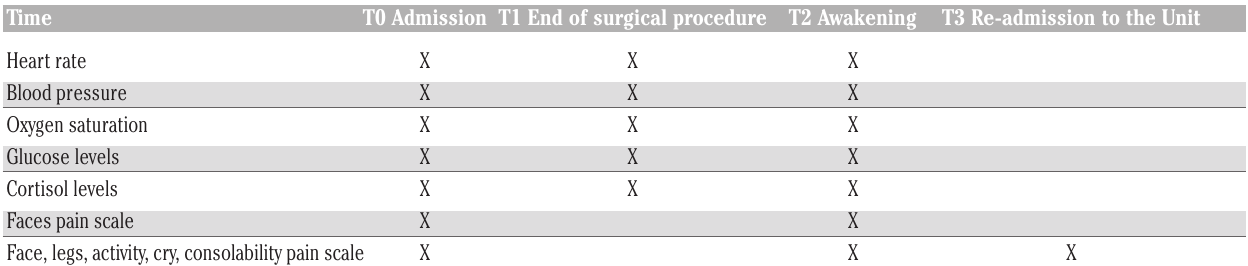
Table 2. Evaluations of vital signs, metabolic and endocrinological parameters and pain scales at time points.